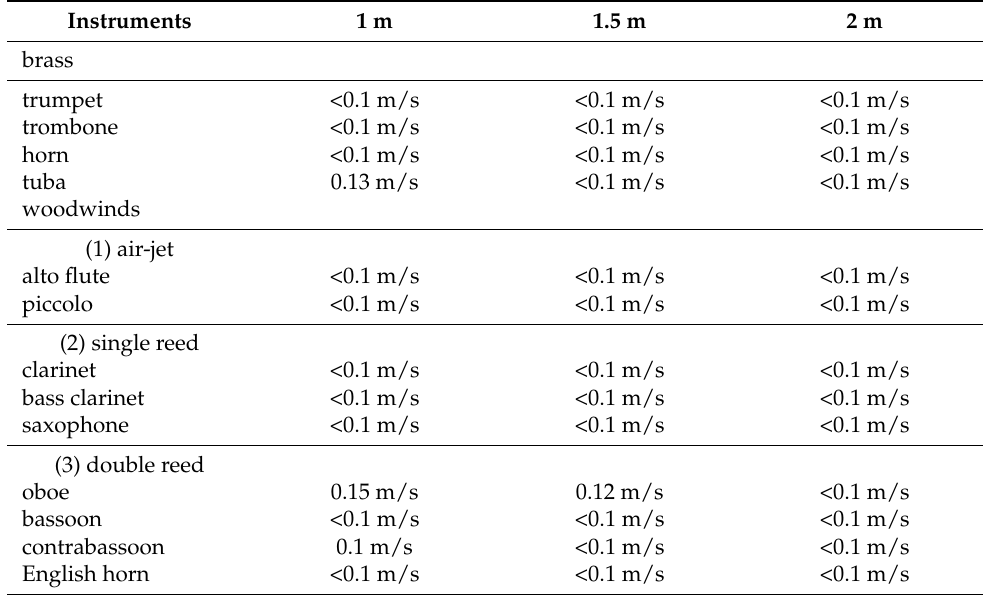
Table 1. Maximal measurements of test instruments, while playing an excerpt from a music